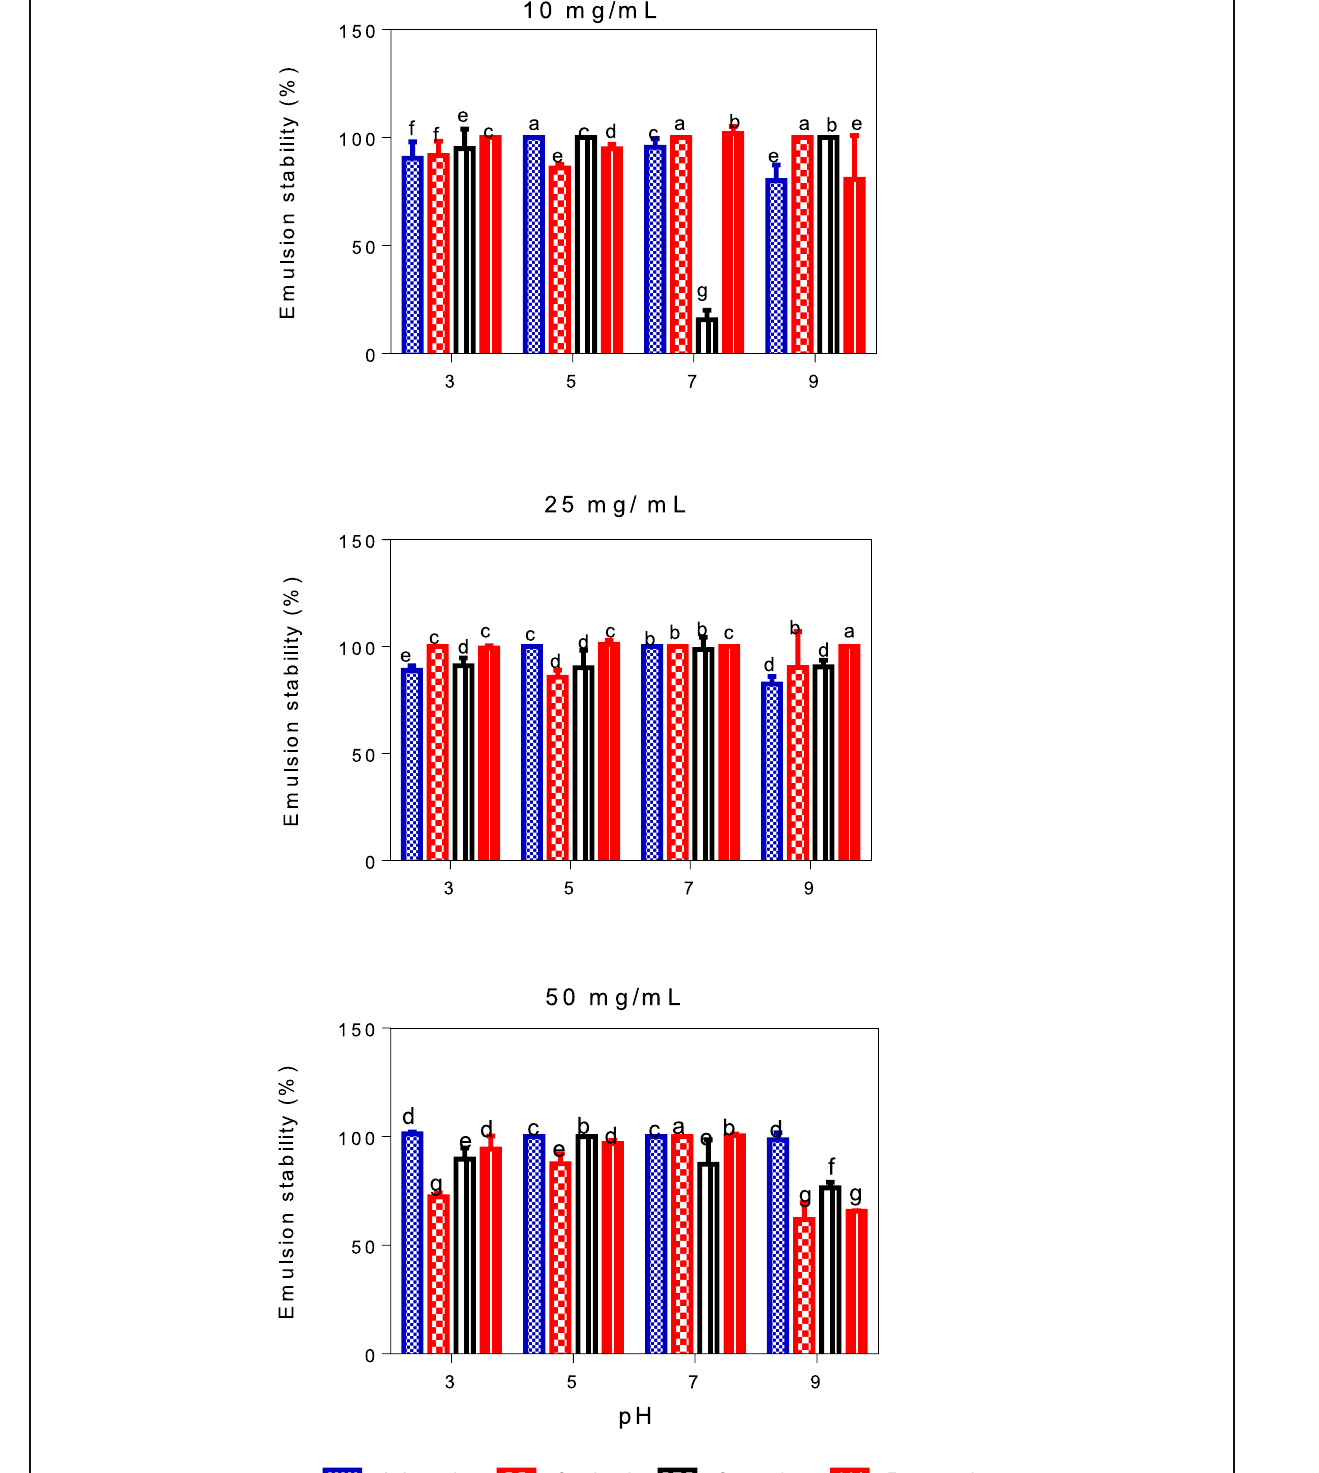
Fig. 9 Effect of pH and sample protein concentration on emulsion stability of protein